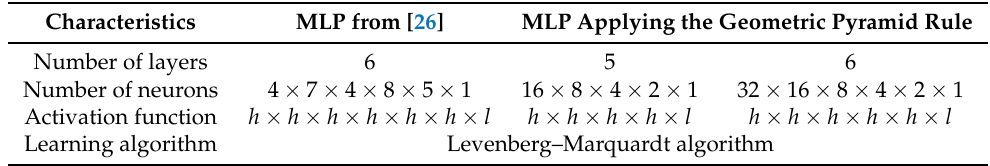
Table 3. Characteristics of three MLPs: the one from [26] and the others designed by applying the geometric pyramid rule with five and six layers.